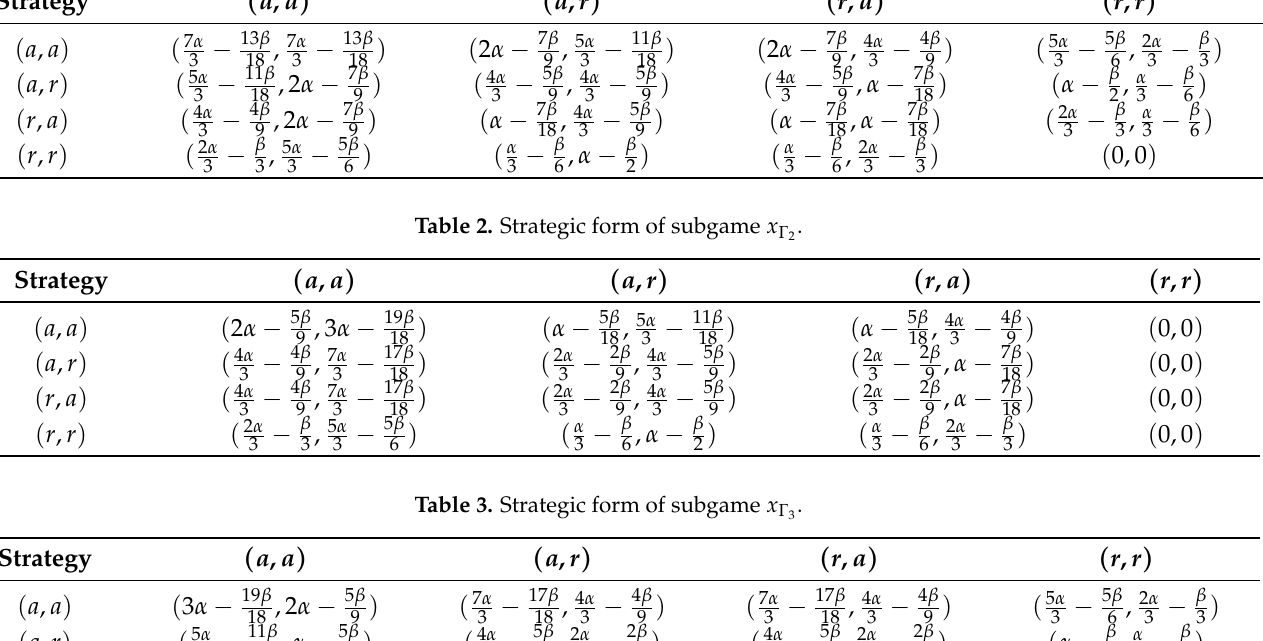
Table 1. Strategic form of subgame x Γ